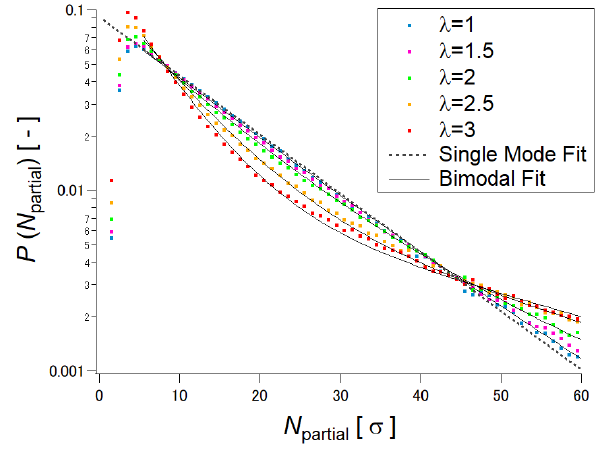
Figure 6. Distribution of segment number between cross-links for SR gel under uniaxial deformation. Reprinted from [27] with permission from American Chemical Society.